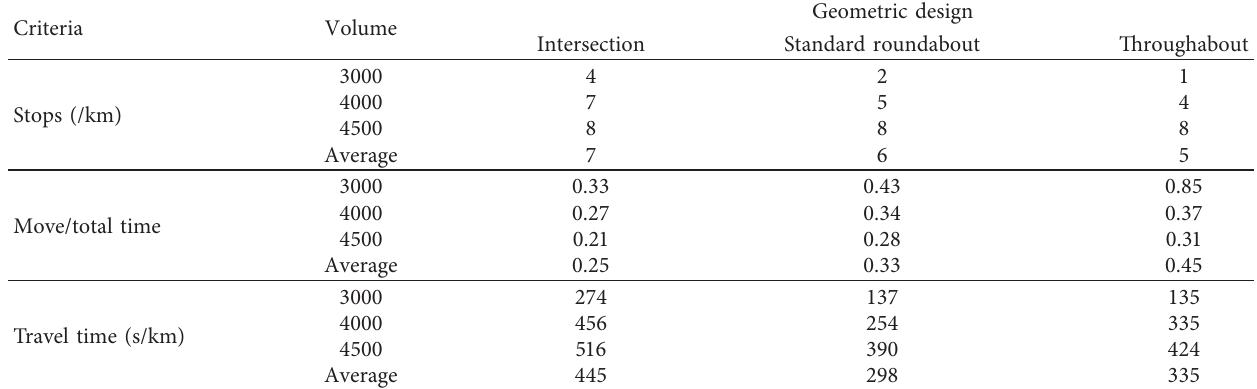
Table 5: Travel time and movement smoothness indexes in the signalized intersection.